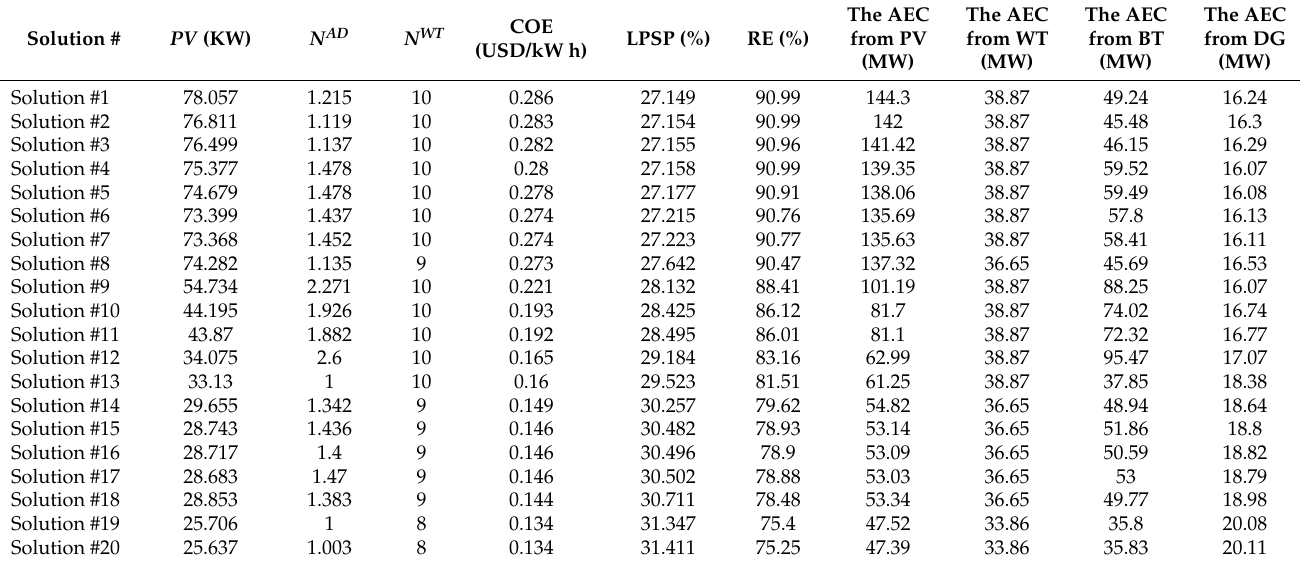
Table 7. Selected solutions from the Pareto front of MODA.